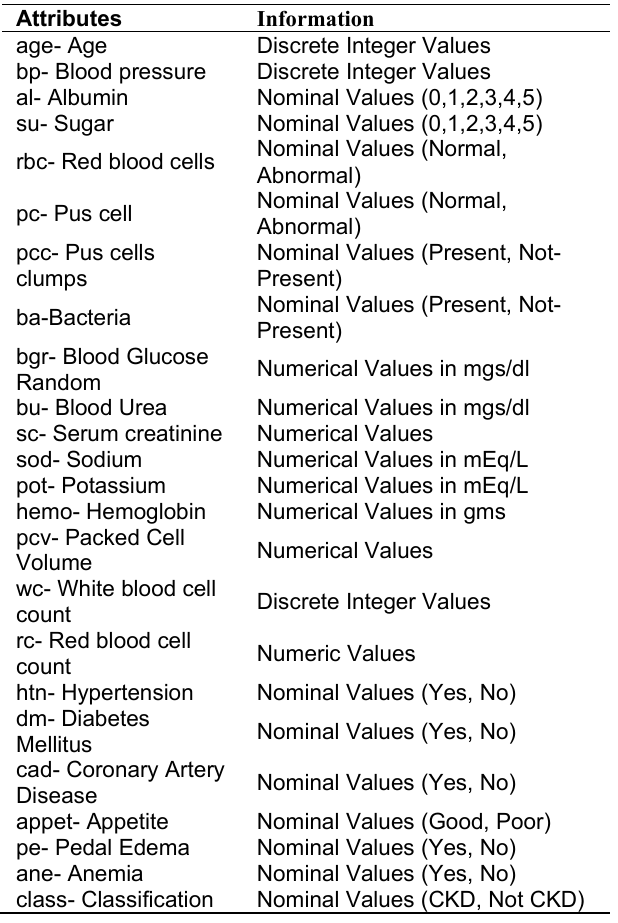
Table 1. Description of Attributes with